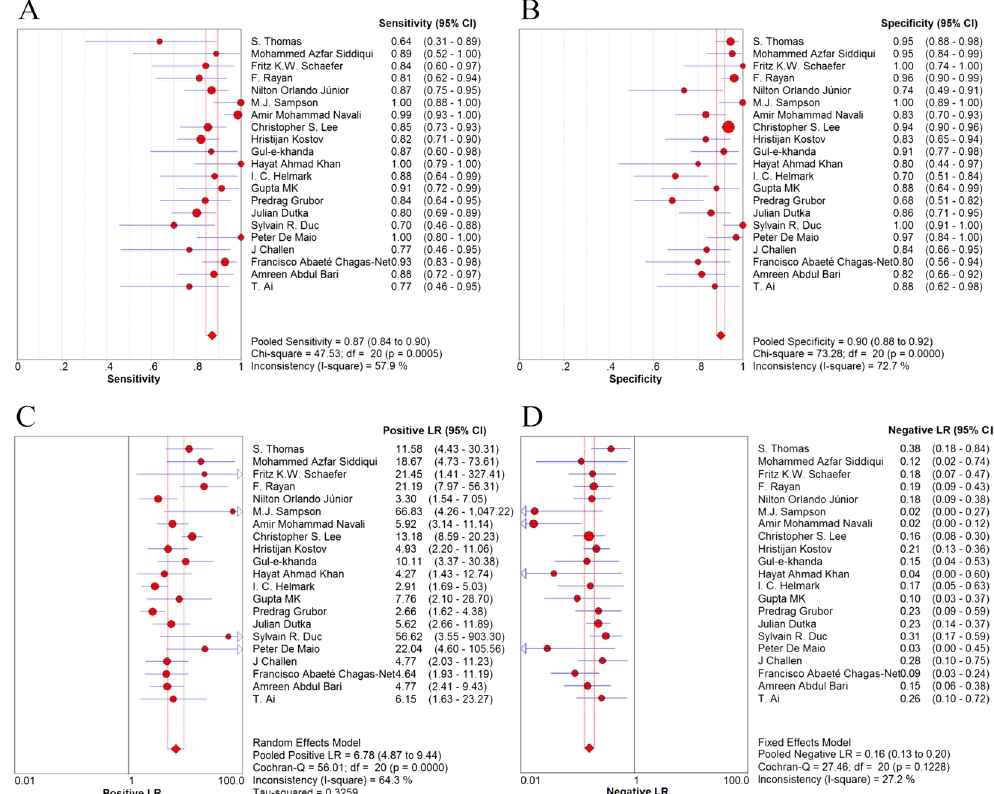
Figure 3. Forest plot of sensitivity, specificity, positive LR and negative LR of MRI for the diagnosis of ACL injury. ( A ) Sensitivity for MRI. ( B ) Specificity for MRI. ( C ) Positive LR for MRI. ( D ) Negative LR for MRI. Corresponding indices, 95% CI and the pooled indices are represented by red circles, horizontal lines and red diamonds, respectively. LR: likelihood ratio; CI: confidence interval.